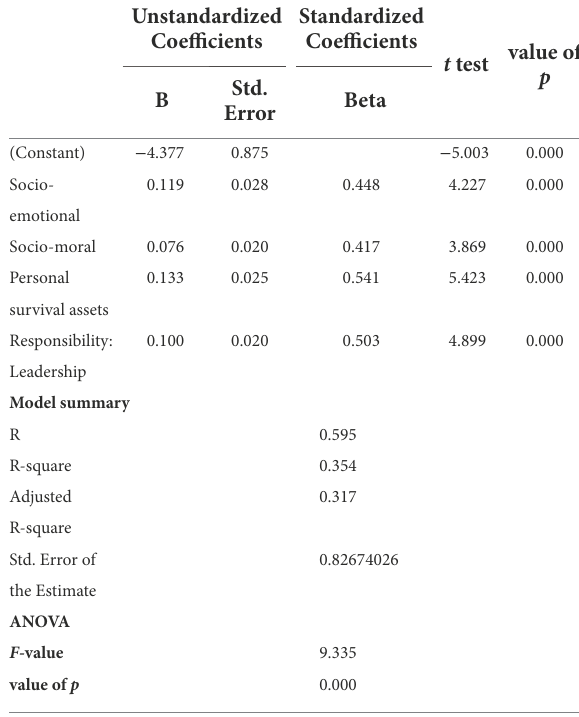
TABLE 5 Regression analysis estimating the effect of resilient cultural practices on cognitive skills.